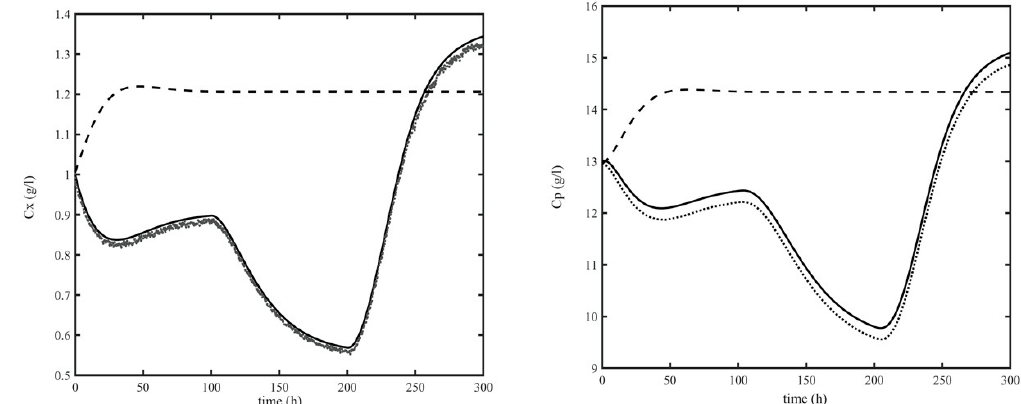
Figure 8. Dynamic response of biomass concentration and ethanol concentration calculated with the virtual plant (continuous line), open-loop model (dashed line) and extended Kalman filter (EKF) (dotted line) for structure φ p3 along the trajectory T3.